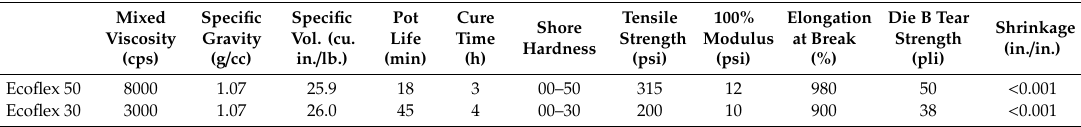
Table 1. Ecoflex sample technical data